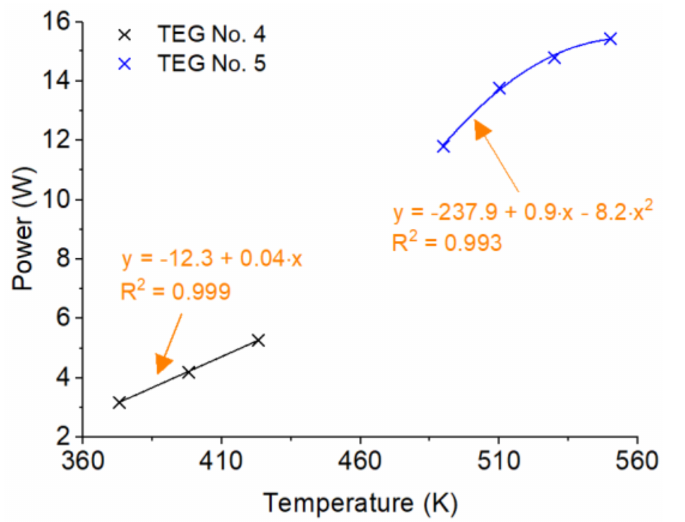
Figure 16. Variations in the generated power as a function of flue gas temperature (on the examples of TEG No. 4 and TEG No.